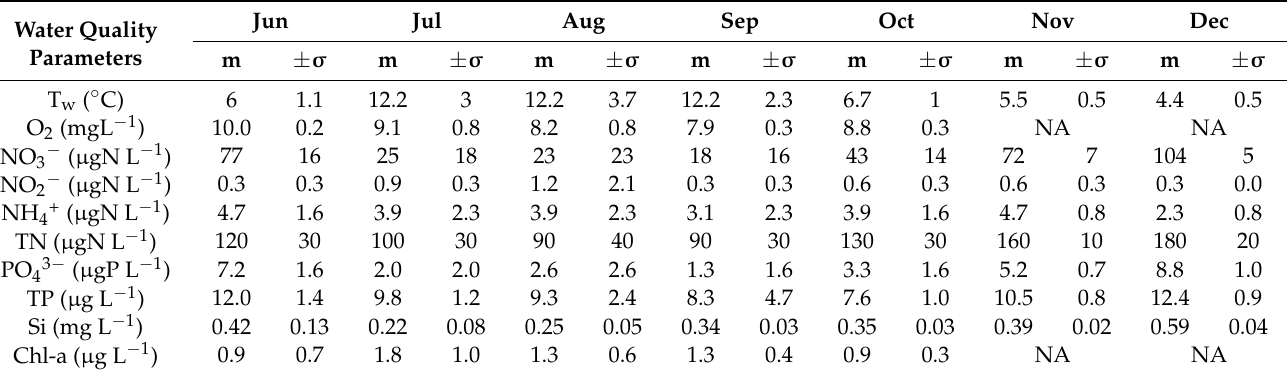
Table 1. Mean concentration ( ± standard deviation) of hydrochemical parameters of water in littoral zone of South Baikal.